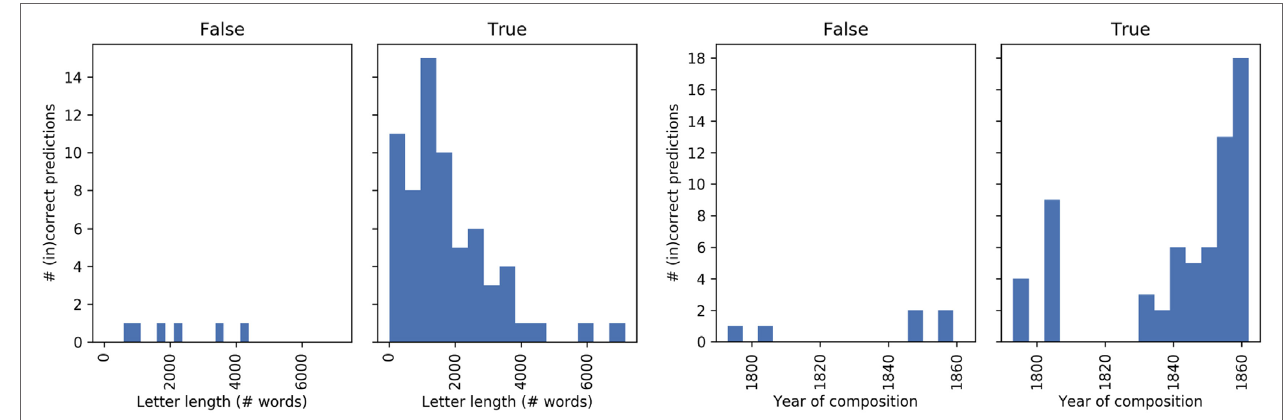
FigUre 9 | Distribution of correct (true) and incorrect (false) predictions in the MAN data-set in terms of length, expressed in number of characters (left) and date